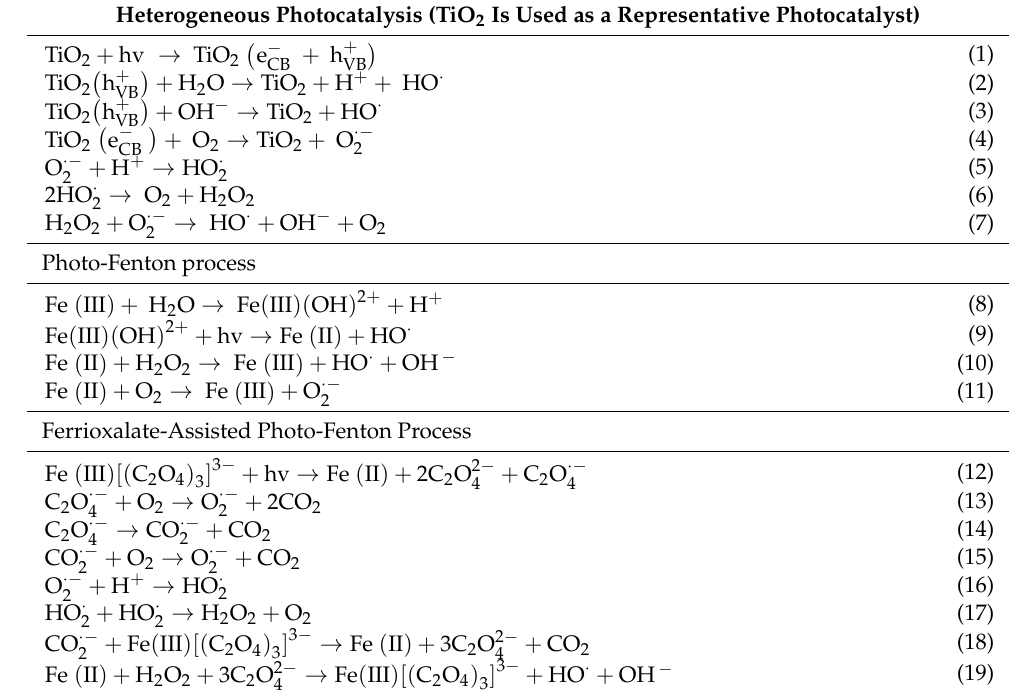
Table 2. Heterogeneous and homogeneous photocatalysis mechanisms [1,13,16,18]. Heterogeneous Photocatalysis (TiO 2 Is Used as a Representative